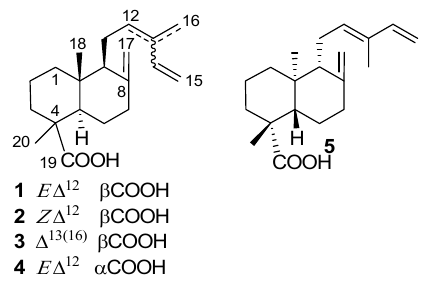
Figure 1. Structure of the communic